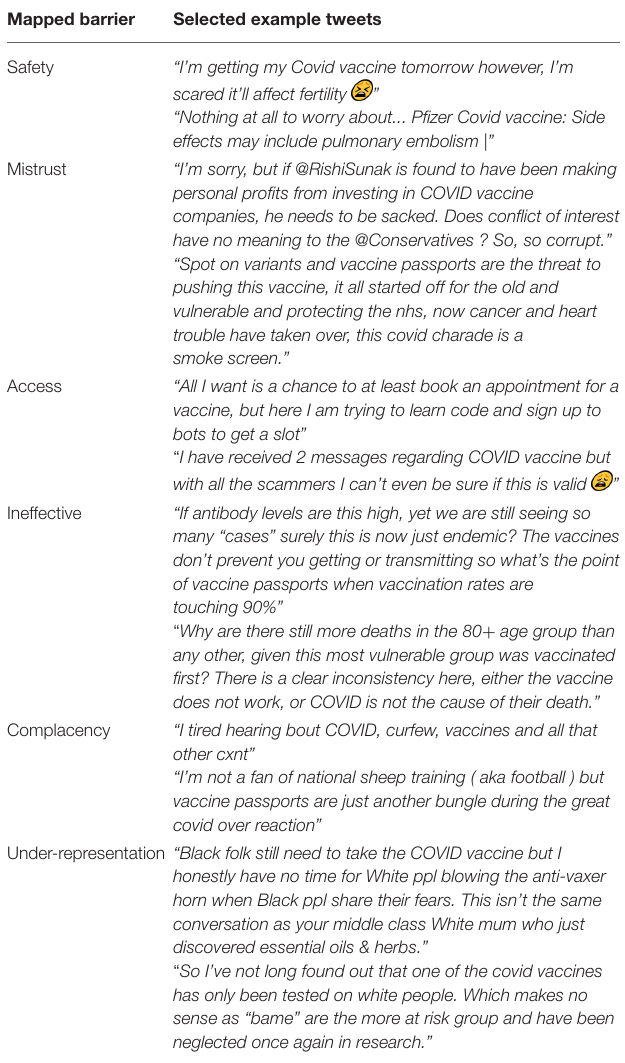
TABLE 1 | Exemplar tweets mapped to each theme. Mapped